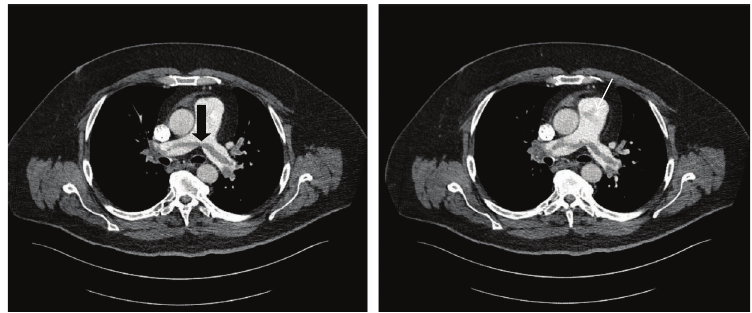
Figure 2: Computed Tomographic Pulmonary Angiogram (CTPA) showing massive saddle pulmonary embolus (bold arrow) with hypo- dense area at the root of pulmonary artery consistent with other emboli (white arrow).